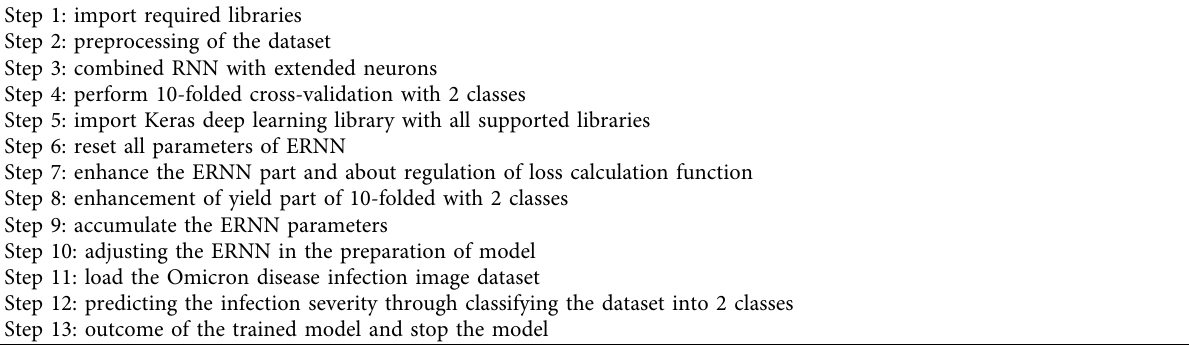
Table 4: Algorithm steps of the ERNN approach.